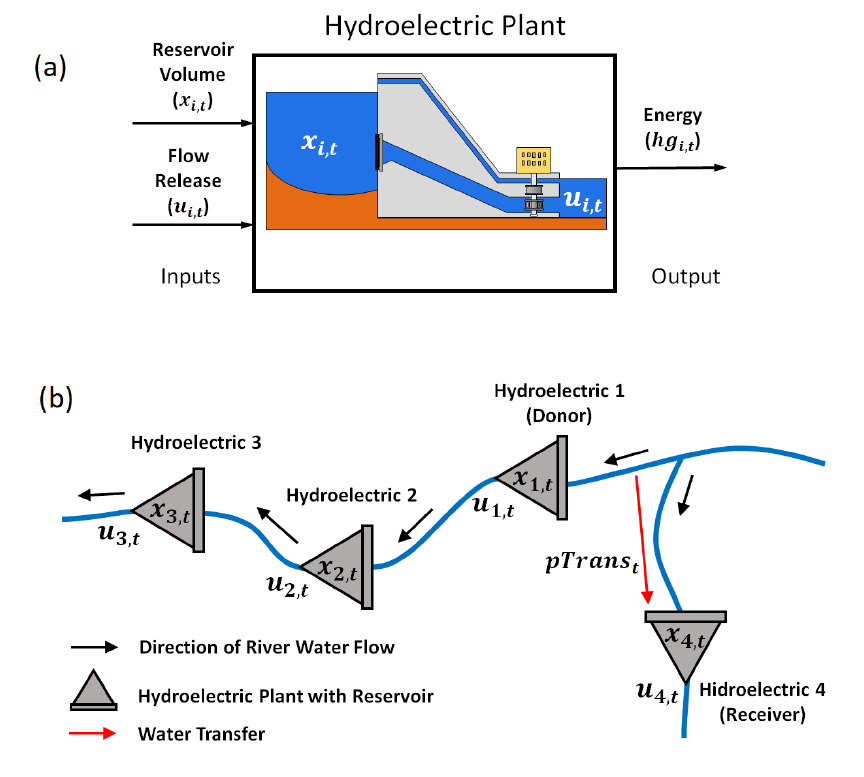
Figure 1. ( a ) Decision variables used in the mathematical modeling of the Hydrothermal Coordination Problem; ( b ) Cascading Hydroelectric System representing the decision variables. The variable pTrans t presented in ( b ) corresponds to the amount of water to be transferred from a donor plant to a recipient plant in time interval t